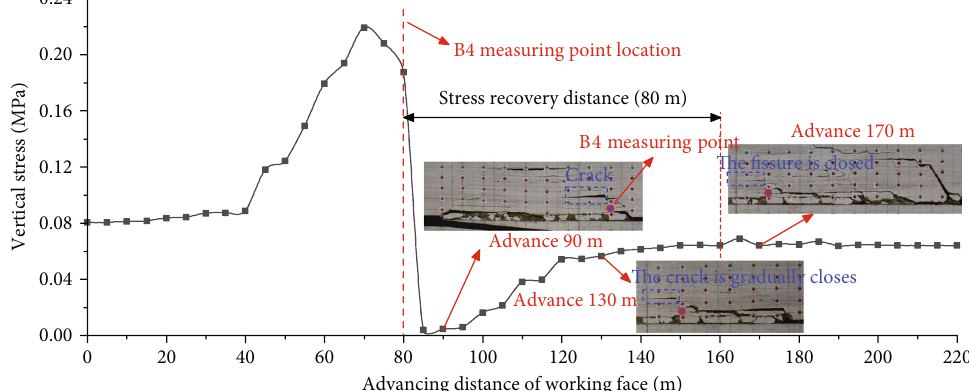
Figure 7: Relationship between stress recovery and dynamic evolution of crack